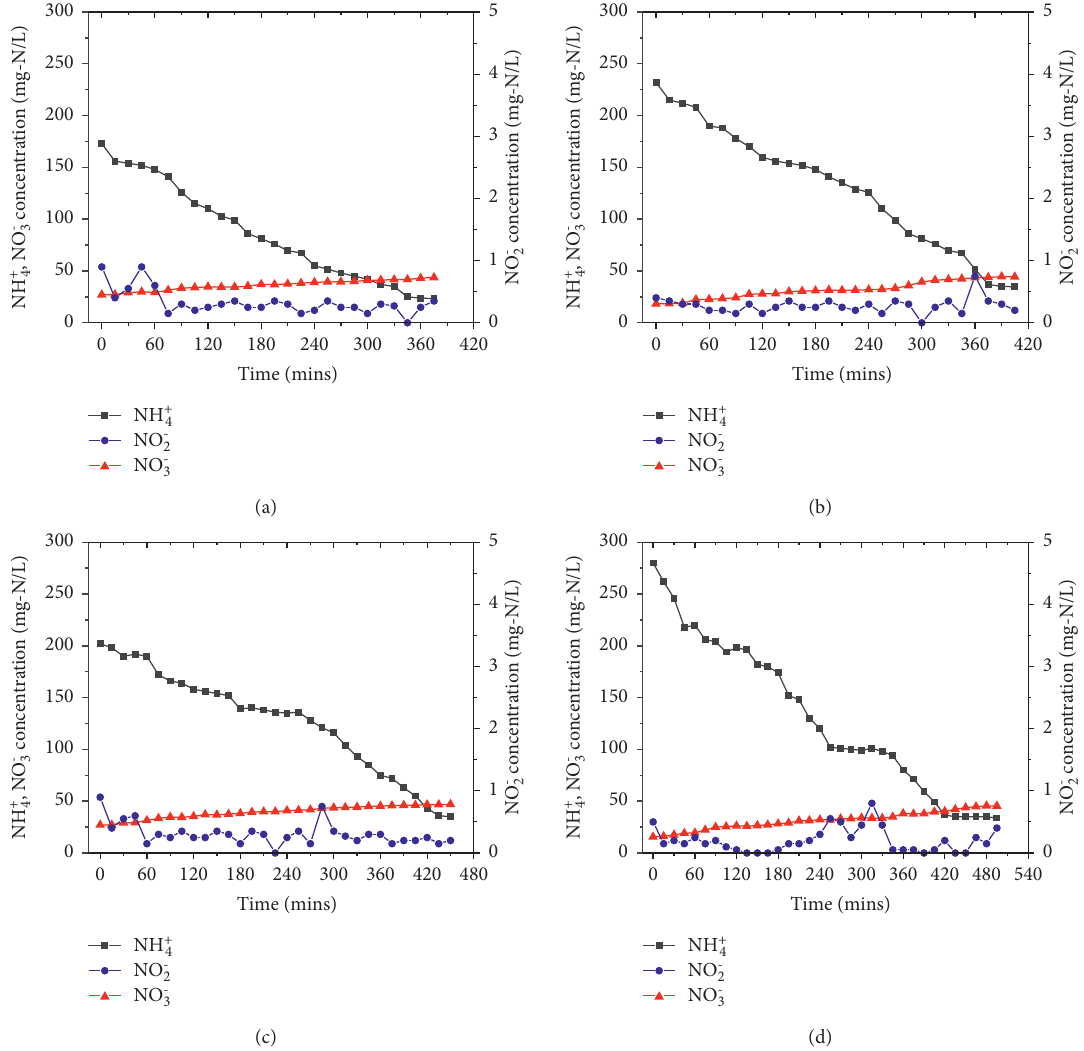
Figure 6: NH + , NO − , and NO − concentration changes in and out of water take influent concentration 173, 232,201, and 280mg NH 4 -N/L, 2 3 4 graphs